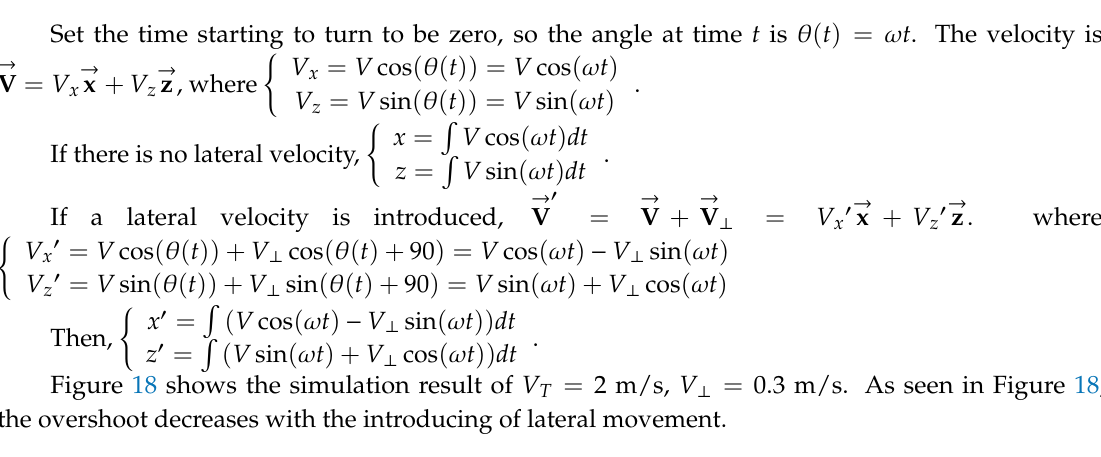
Figure 17. Turning at the corner.